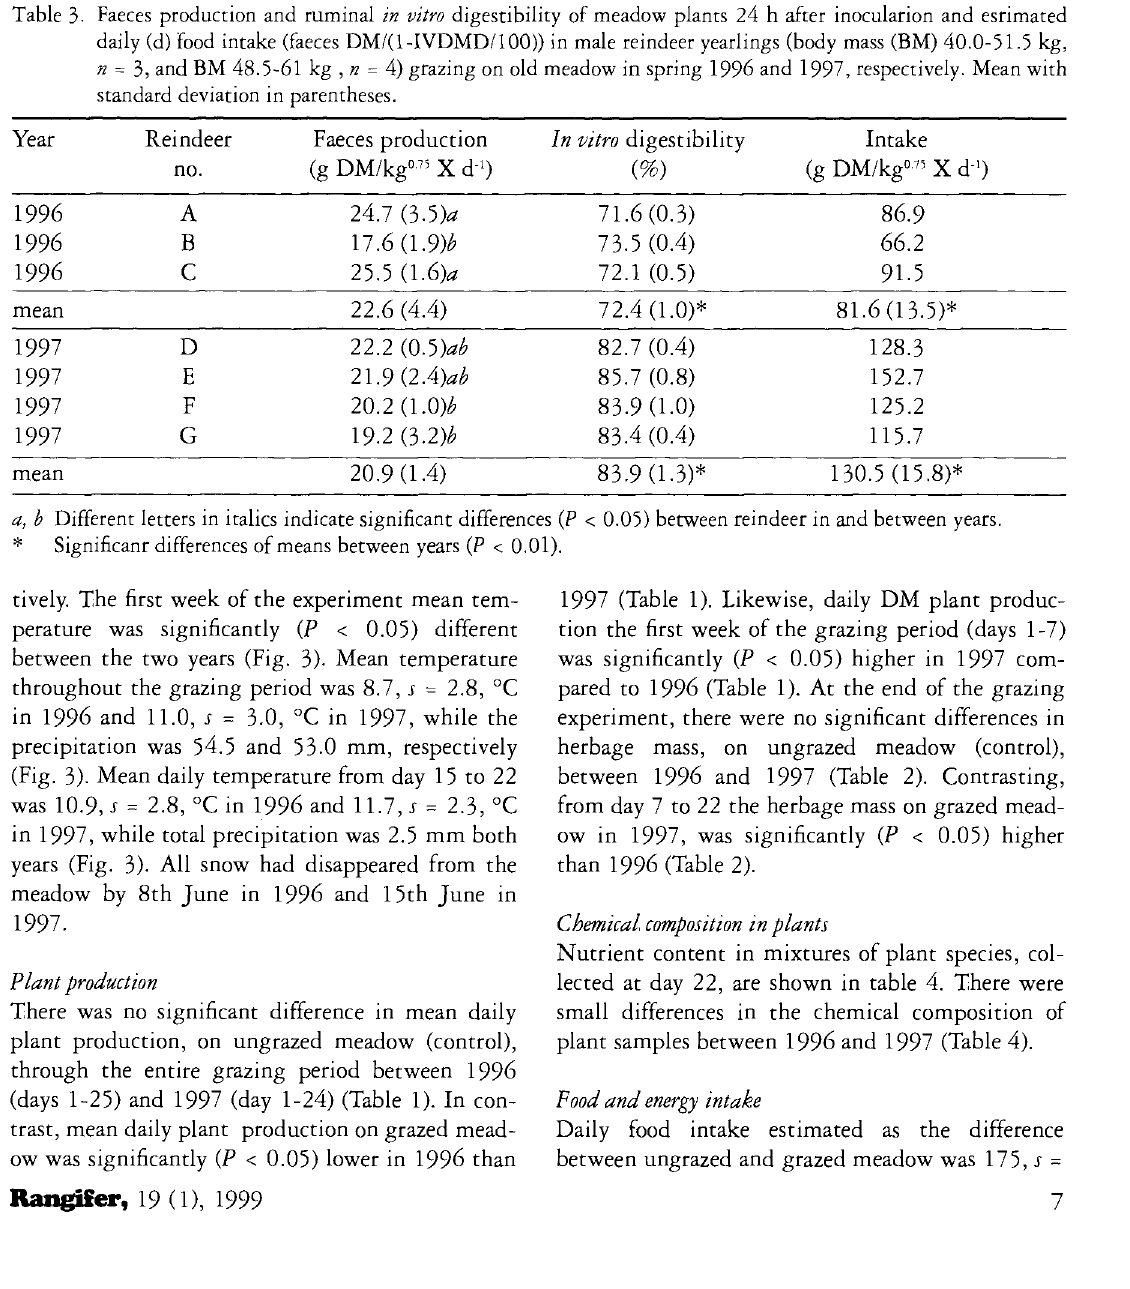
Table 3. Faeces production and ruminal in vitro digestibility of meadow plants 24 h after inocularion and esrimated daily (d) food intake (faeces DM'(l-IVDMD'lOO)) in male reindeer yearlings (body mass (BM) 40.0-51.5 kg, n = 3, and BM 48.5-61 kg , n = 4) grazing on old meadow in spring 1996 and 1997, respectively. Mean with standard deviation in